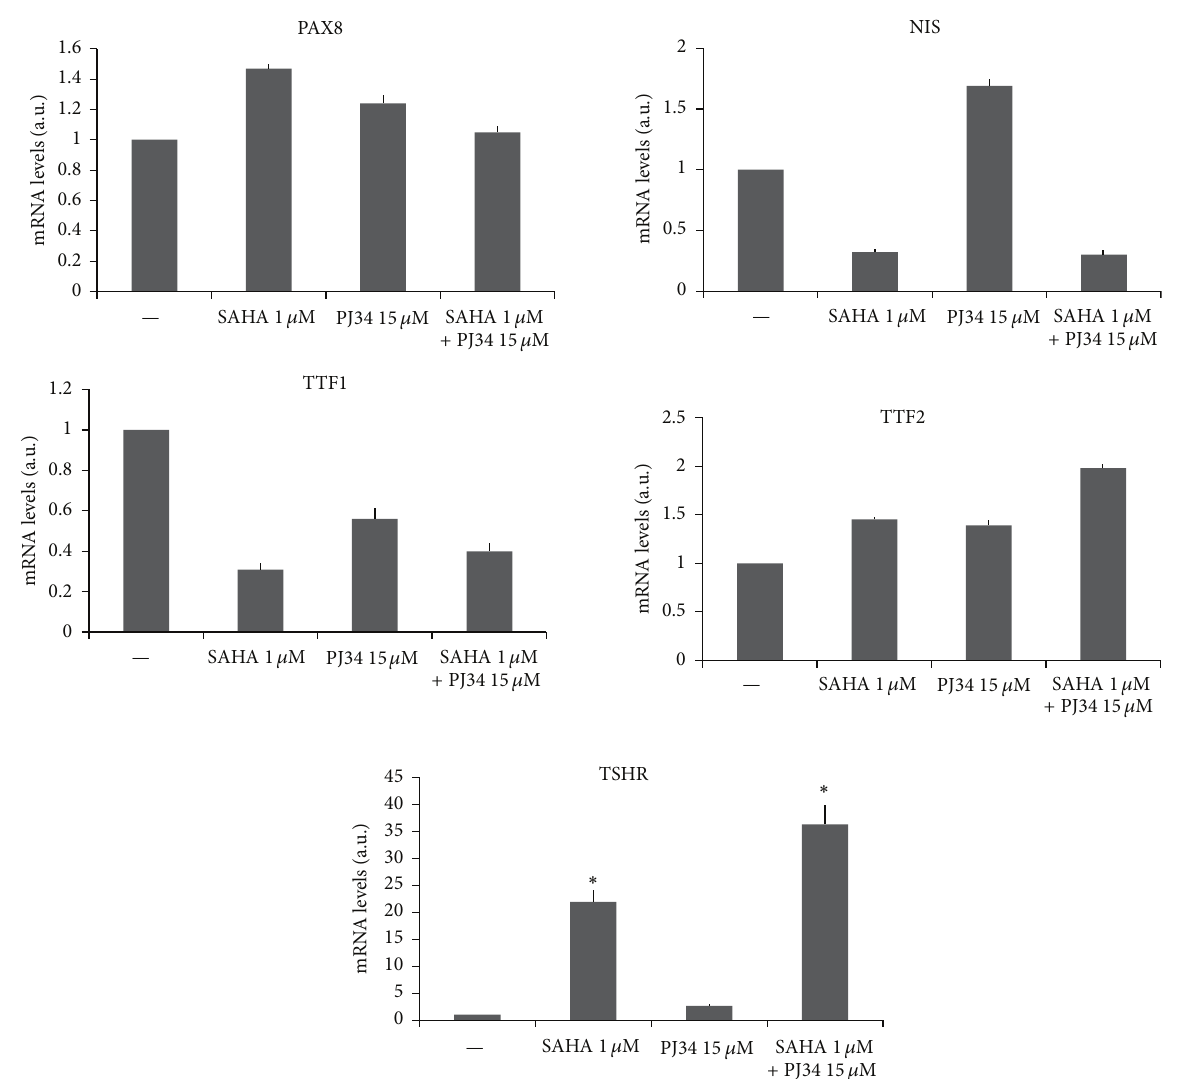
Figure 4: Expression levels of PAX8, NIS, TTF1, TTF2, and TSHR genes in SW1736 cell line. RNA extraction and real-time PCR are described in Section 2. For each gene the results were normalized against 𝛽 -actin and expressed in arbitrary unit ( 2 −Δ Ct ). Each bar represents the mean valueofthreedifferentdeterminations.Foreachbarstandarddeviationisnotabove10%ofeachvalue. ∗ indicatesvaluessignificantlydifferent compared to all other